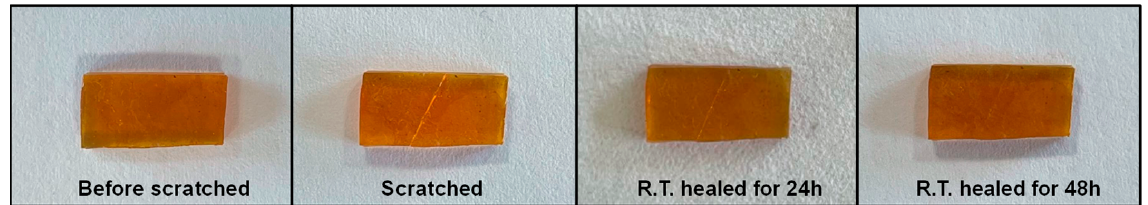
Figure 9. Self-healing effect occurred at room temperature (R.T.).